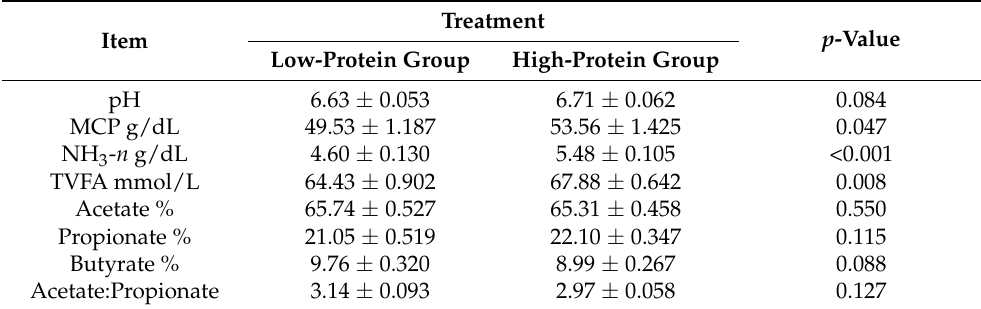
Table 7. Effects of the dietary protein level on the rumen fermentation characteristics of growing yaks.